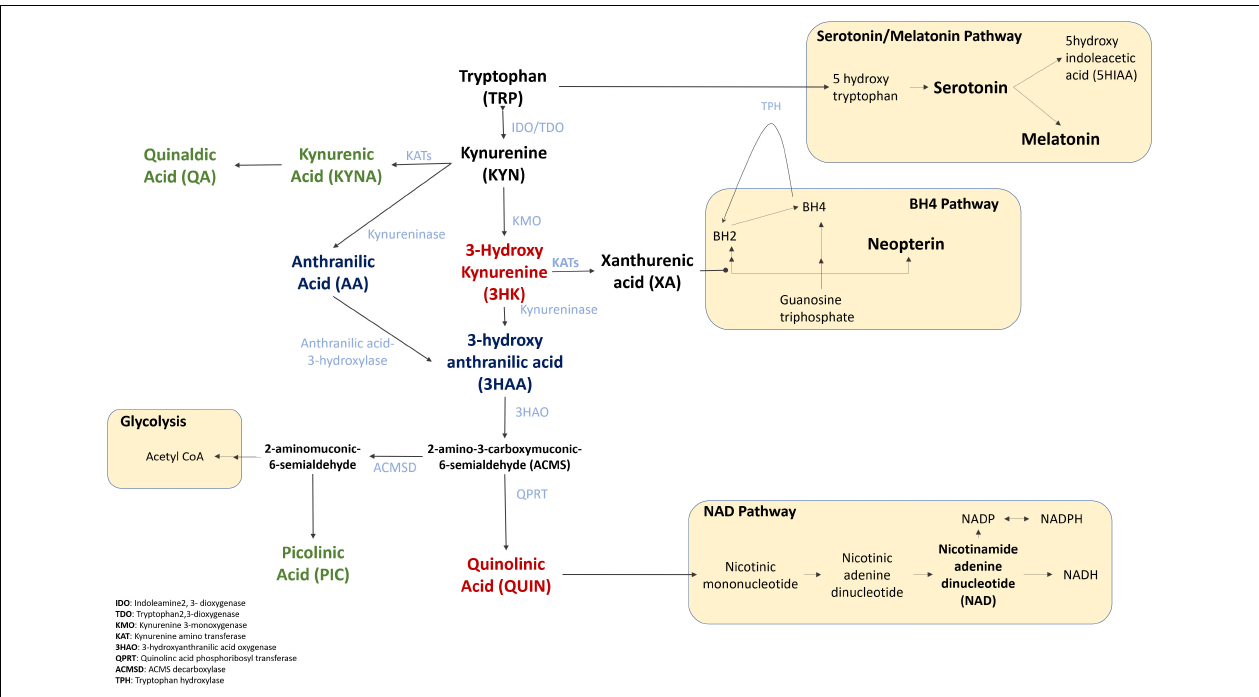
FIGURE 1 | The Kynurenine Pathway and its downstream pathways of Serotonin/Melatonin, BH4, Glycolysis, and NAD+. Tryptophan is converted into serotonin and melatonin, that regulate mood and sleep. The tetrahydrobiopterin (BH4) pathway interacts with the KP in three ways, (1) the sharing of the enzyme TPH that degrades tryptophan, (2) the inhibition of a key BH4 pathway enzyme, sepiapterin reductase, (3) both BH4 and KP are induced by inflammatory cytokines. Tryptophan also feeds into the glycolysis cycle via ACMS, affecting ATP production. Finally, the KP is the de novo synthesis pathway of NAD+ which is associated with cellular energy, repair and fatigue. The key KPMs are bolded, neurotoxic metabolites represented in red, neuroprotective metabolites in green, and dual functioning in